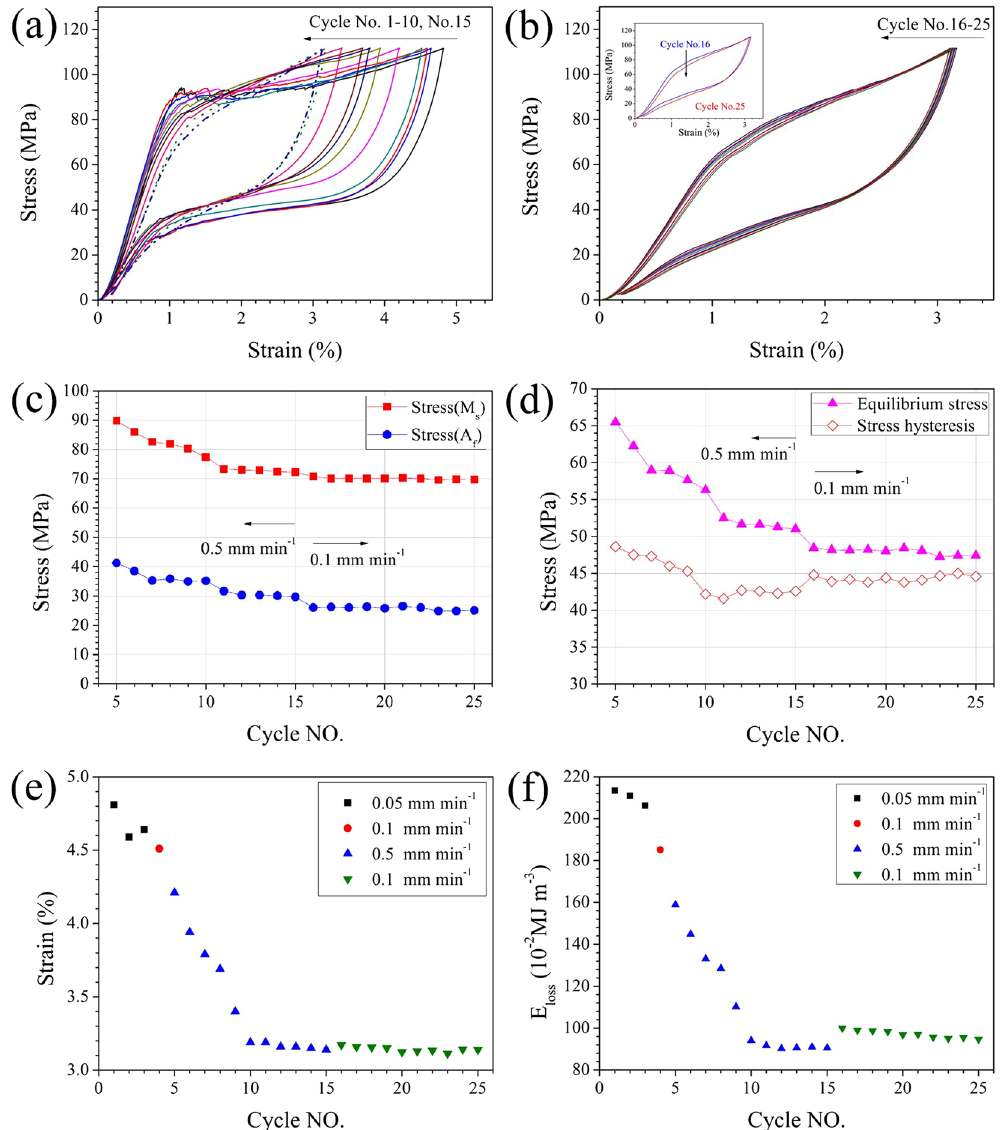
Figure 6. Isothermal stress–strain responses (cycles No.1–15 for ( a ), cycle Nos.16–25 for ( b )), critical transformation stress ( c ), equilibrium stress and stress hysteresis ( d ), total strain ( e ) and hysteresis energy loss ( f ) upon cycling loading and unloading of Ni 45 Mn 50 − x In x Co 5 (x = 13.6) samples at low strain rates (0.05–0.5 mm min − 1